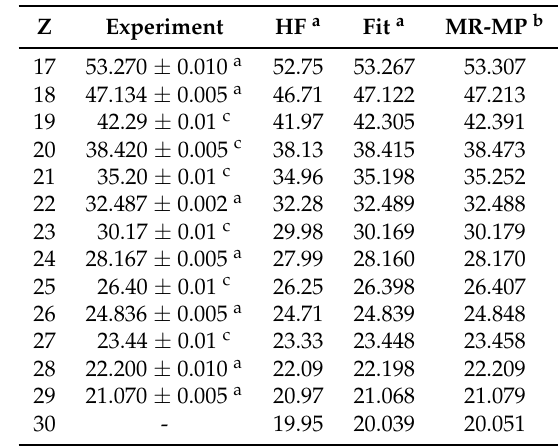
Table 1. Comparison of experimental 2s 2 2p 5 3s3p 4 D 7/2 – 2s2p 5 3s3d 4 F o (in nm) in ions of the Na I isoelectronic sequence with single-configuration Hartree–Fock (HF, Cowan code) calculations, semi-empirical adjustment of the same by fitting the calculation to the data, and ab initio Multi-reference Møller-Plesset (MR-MP)